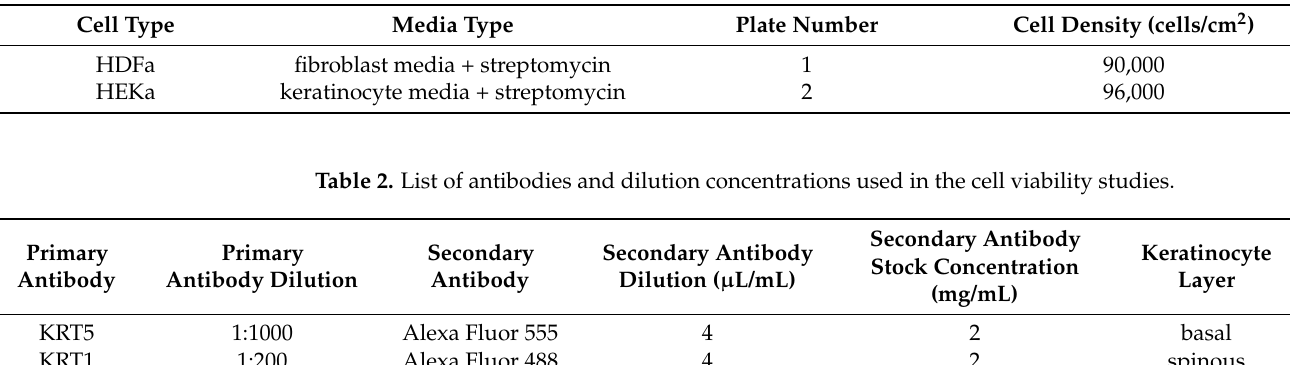
Table 1. Well-plate arrangements of the test scaffolds.